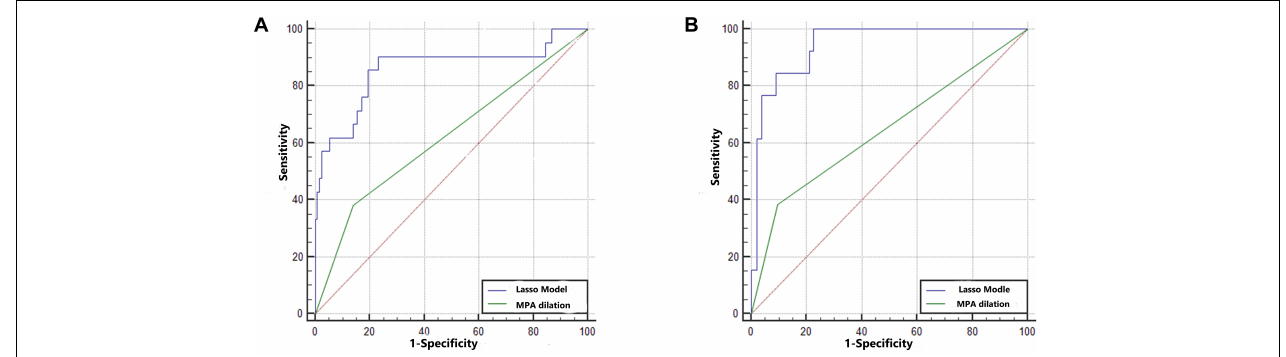
FIGURE 5 | The predictive ability of the training set and validation set. (A) The AUCs in the training set were 0.860 (95% CI: 0.795–0.912) and 0.621 (95% CI: 0.538–0.699). The difference between the predictive formula and the MPA dilation measurement was 0.240 (95% CI: 0.115–0.364, p < 0.001). (B) The AUCs in the validation set were 0.887 (95% CI: 0.892–0.975) and 0.643 (95% CI: 0.560–0.721). The difference between the predictive formula and the MPA dilation measurement was 0.300 (95% CI: 0.164–0.436, p <